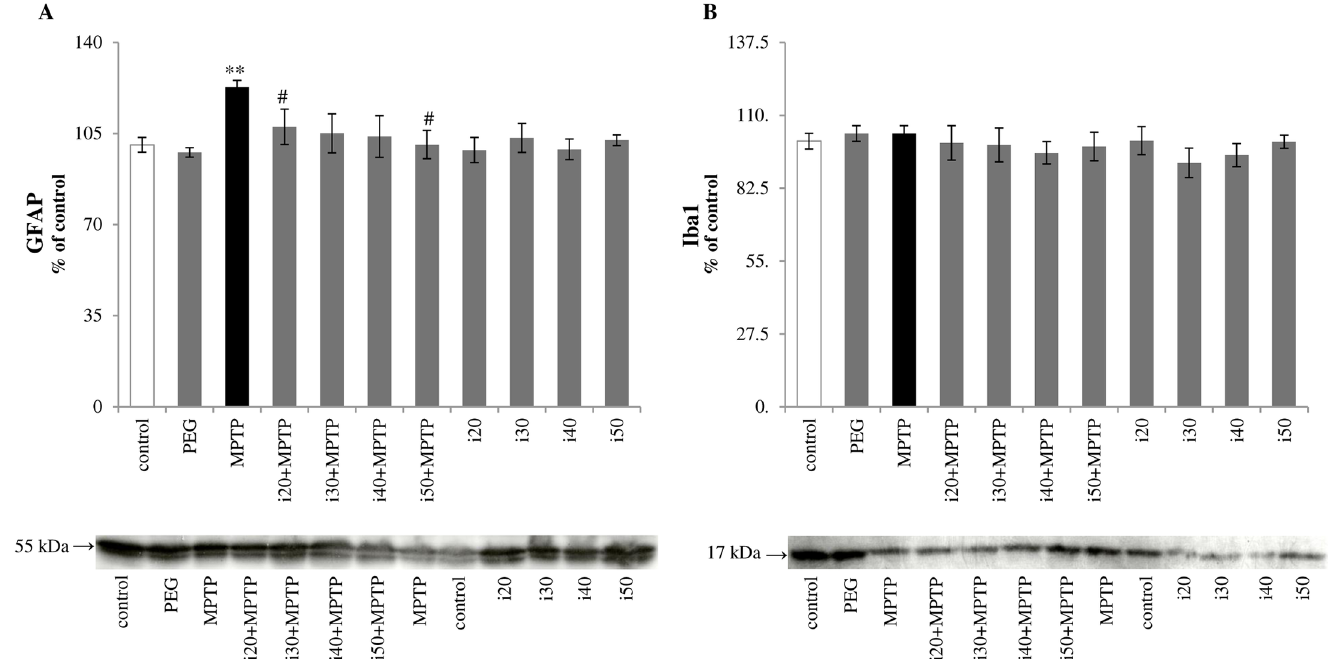
Fig 2. Protein expression of (A) GFAP and (B) Iba1 in the striatum, evaluated by immunoblot analysis. Abbreviations of groupsof animals: control– saline-treated; PEG–vehicle-treated; MPTP–MPTP-intoxicated; i(20, 30, 40, or 50)+MPTP–IBD [20, 30, 40, or 50 mg/kg] and MPTP-treated; i(20, 30, 40 or 50)–IBD [20, 30, 40, or 50 mg/kg] treated. The values are expressedas mean ± SEM, for five mice per group ( * represents a significantdifference relativeto control group, ** p < 0.01; # represents a significantdifference comparedwith the MPTP group, # p < 0.05;Mann Whitney U